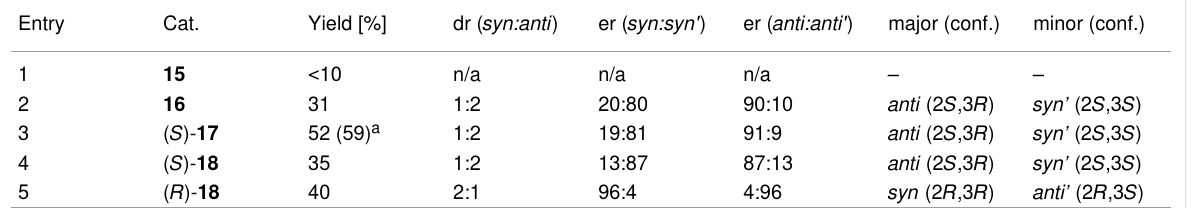
Table 1: Stereoselectivity of α -photooxygenation reaction of 3,4-diphenylbutanal ( 1 ).